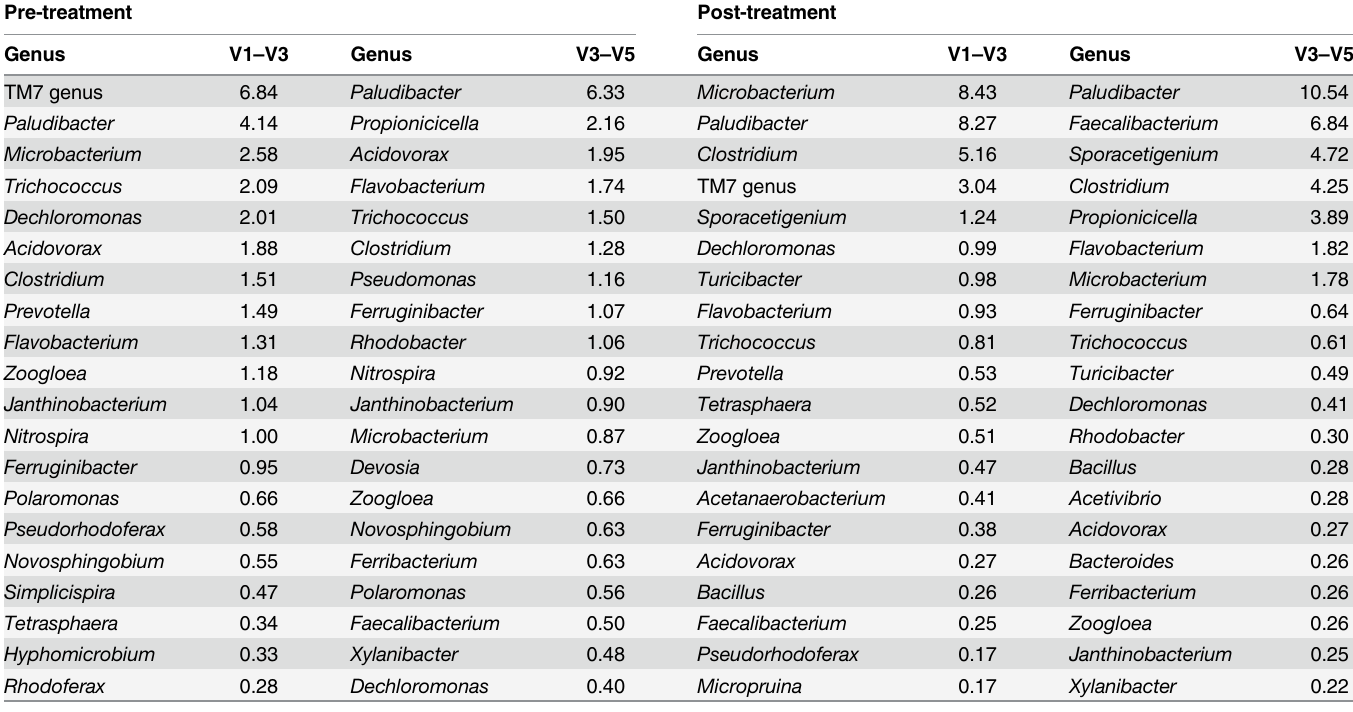
Table 4. Comparison of the 20 most abundant genera determined by 16S amplicon sequencing in Plant C biosolids (May 12, 2009).